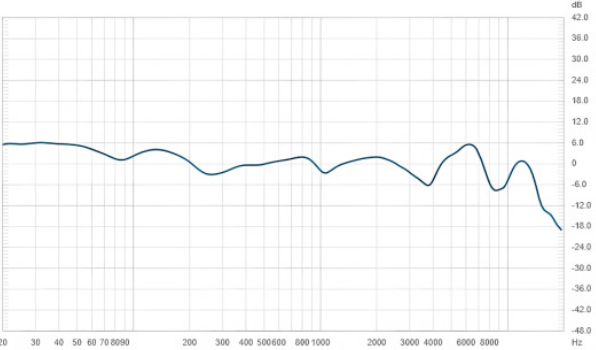
Figure A1. Frequency response of the Sennheiser HD 215 headphones.